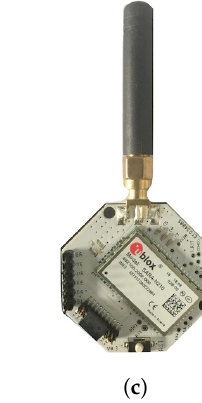
Figure 5. LPWAN modules used in the experiment for the energy analysis ( a ) LoRa/DASH7 module; ( b ) Sigfox module; ( c ) NB-IoT